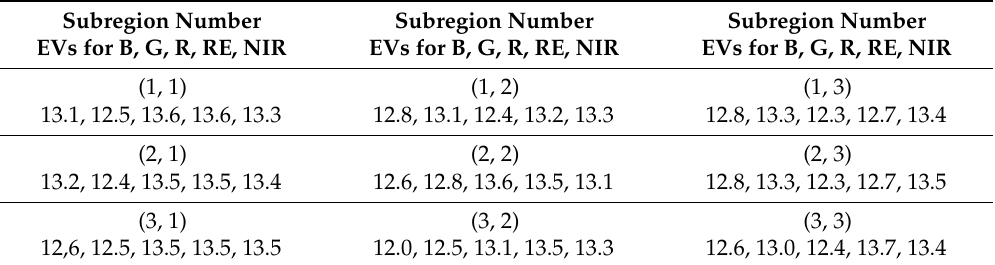
Table 4. Root mean square error (RMSE) of the three calibration methods for validation data.